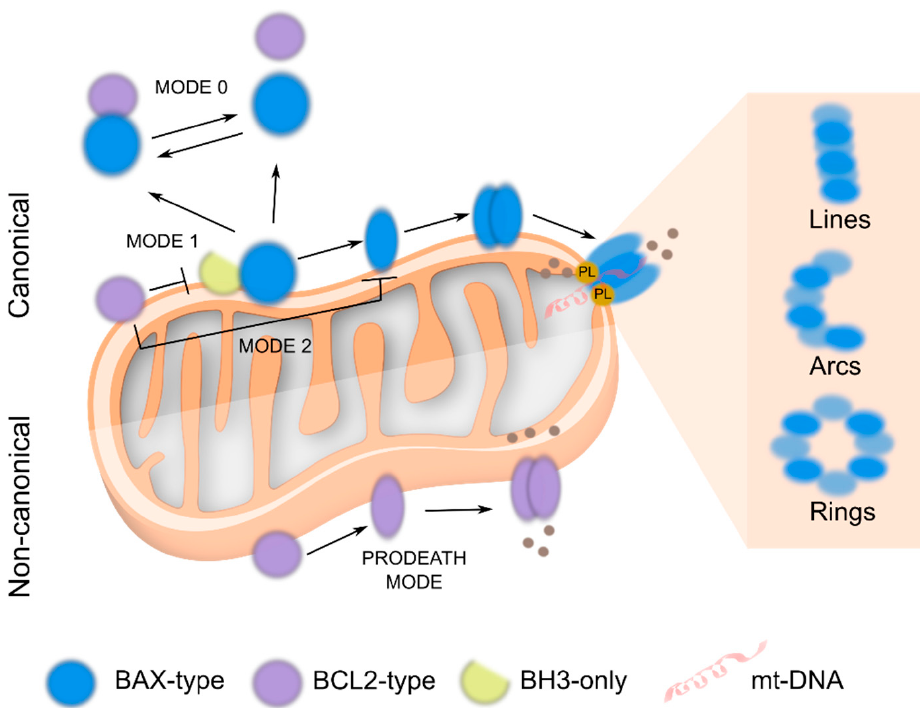
Figure 1. The BCL2 puzzle. Canonical BAX/BAK activation . Activation of BAX-type proteins at the mitochondrial outer membrane (MOM) by the BH3 only proteins induces their oligomerization, formation of supramolecular structures (lines, arcs and rings) and pore formation with the consequent release of apoptogenic factors. The apoptotic repressors, block this process by either interacting with BH3 only proteins (MODE1) or with BAX-type proteins in the membrane (MODE 2) or translocating them to the cytosol (MODE 0). Non canonical cell death or PRODEATH MODE of BCL2-type proteins. Under cellular stress, BCL2-type proteins can switch their antiapoptotic phenotype, directly eliciting rather than inhibiting membrane permeabilization. PL: phospholipids; grey balls: apoptogenic factors.